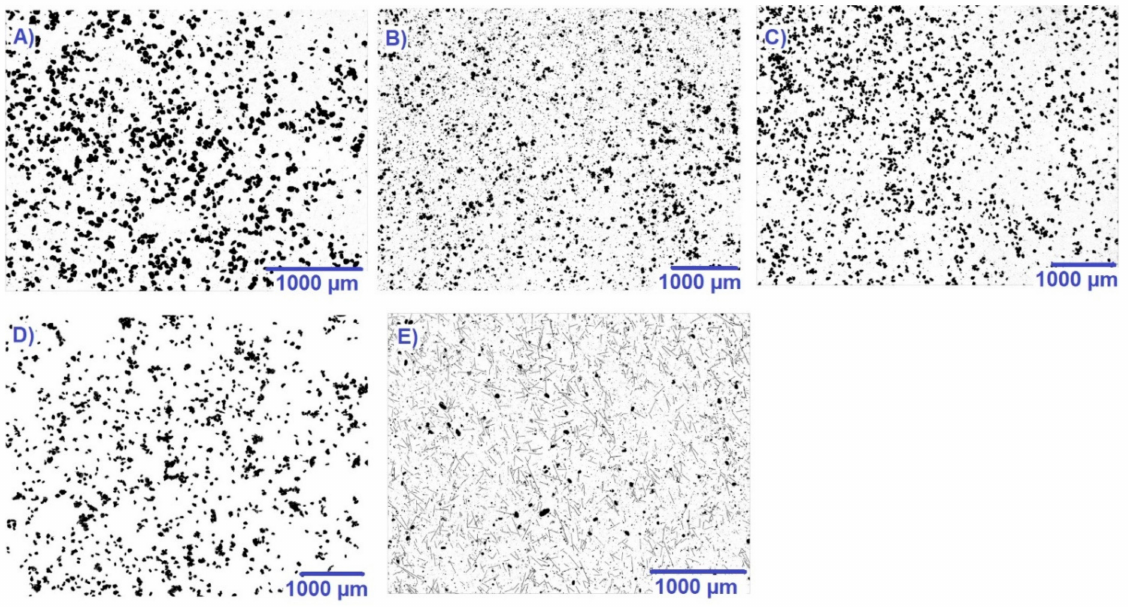
Figure 4. Images from powders observed by confocal microscopy Keyence VHX 6000, ( A )—PA_2200, ( B )—PA_2210_FR, ( C )—PA_3200_GF, ( D )—PA_Alumide, ( E